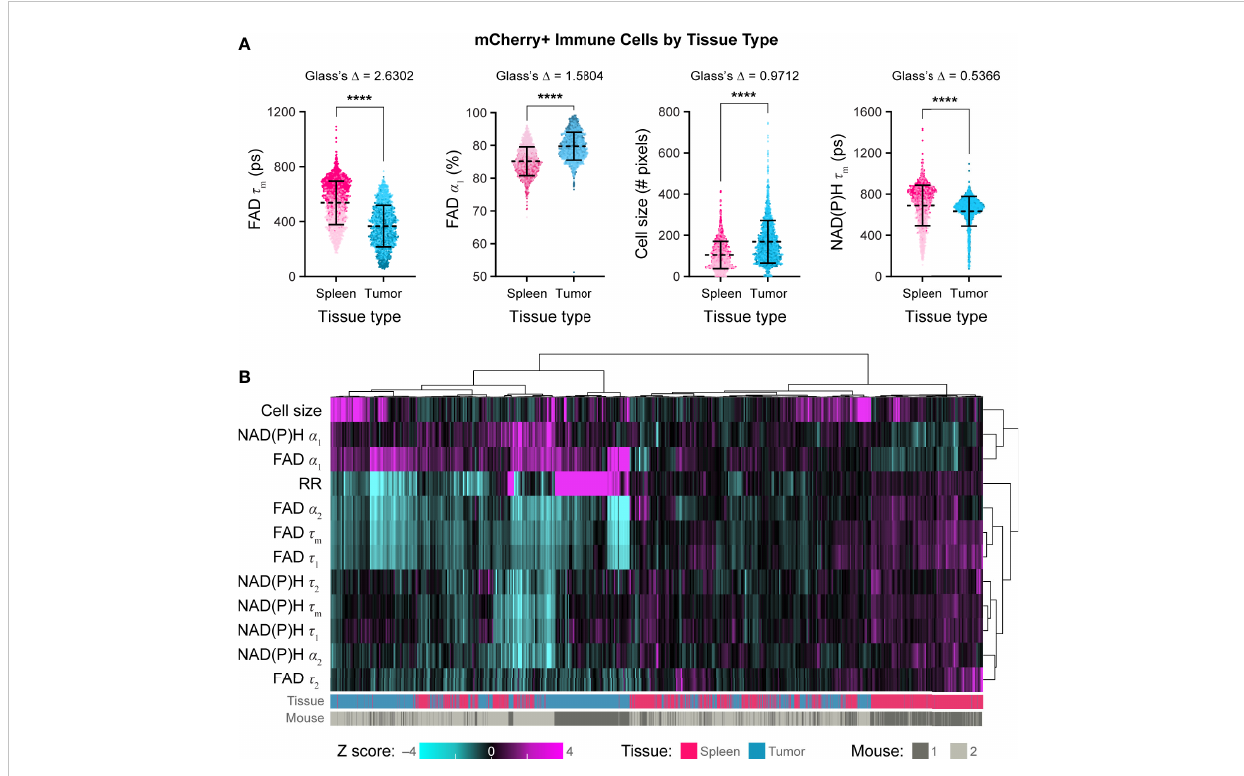
FIGURE 5 In vivo optical metabolic imaging of mCherry+ immune cells within tumor and spleen discriminates metabolic changes based on tissue type. (A) Single cell mCherry+ immune cell OMI parameters from spleen (n = 1672 cells) and B78 tumor (n =1688 cells) across n = 2 mice. Immune cells from B78 tumors exhibit signi fi cantly decreased FAD t m (361 ps vs. 554 ps) and signi fi cantly increased FAD a 1 (90% vs. 85%) compared to immune cells from spleens (Glass ’ s D >0.8). Immune cells from B78 tumors are signi fi cantly larger in size (149 pixels vs. 95 pixels) compared to immune cells from spleens (Glass ’ s D >0.8). Immune cells from B78 tumors exhibit decreased NAD(P)H t m (667 ps vs. 734 ps) compared to immune cells from spleens; though the p value indicates substantial signi fi cance (p<0.0001), only a trend is observed using the more conservative Glass ’ s D test (Glass ’ s D = 0.5366). Data points colored to re fl ect individual replicates acquired on different days. Bars indicate mean ± SD, Mann-Whitney U Test, **** p<0.0001 shown for reference; all Mann-Whitney U Test comparisons are signi fi cant due to the large sample size so Glass ’ s D was also included as a more conservative signi fi cance test, see Methods. (B) Heatmap of z-scores of 12 OMI parameters from immune cells within both spleens and tumors. Hierarchical clustering of single cells indicates data clusters best by tissue type. Each column is a single cell (n = 3360